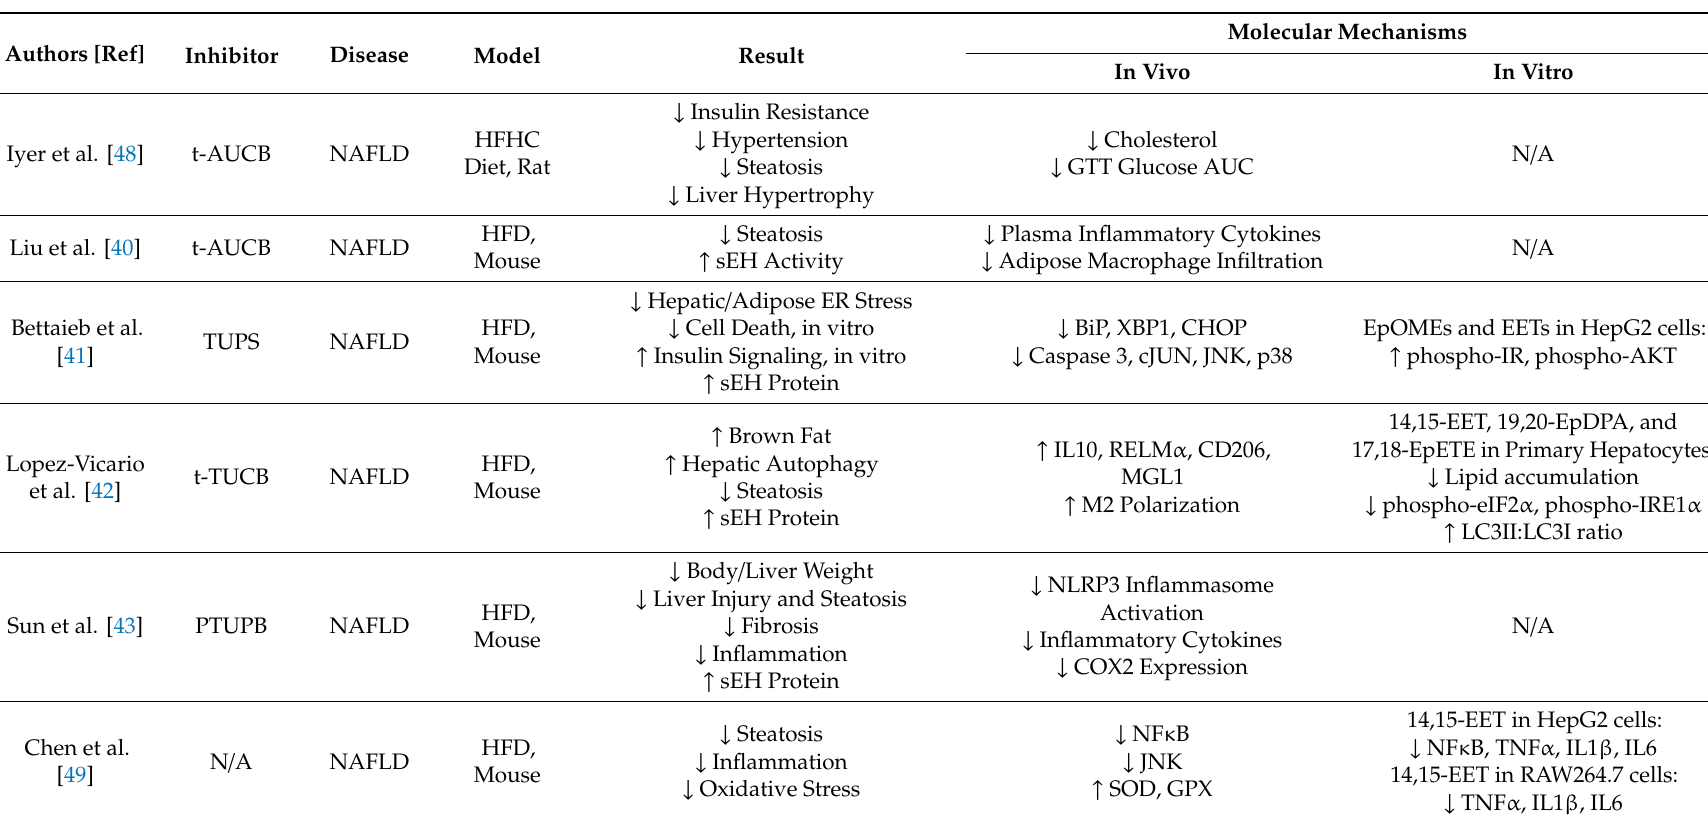
Table 1. Summary of studies investigating the role of sEH in liver diseases. Listed are studies cited in the review, along with details of the experimental design (model, species, and sEHI used) and a brief description of the results and mechanism, if available. Changes in sEH expression or activity are noted in the results column, where